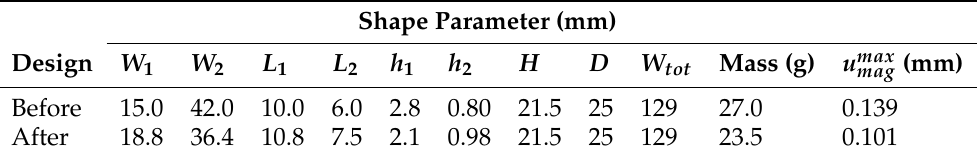
Figure 21. The X-core structure before the IDM shape optimisation ( top ). The X-core structure after the IDM shape optimisation ( bottom ). Table 4. The parameters of the X-core structure before and after shape